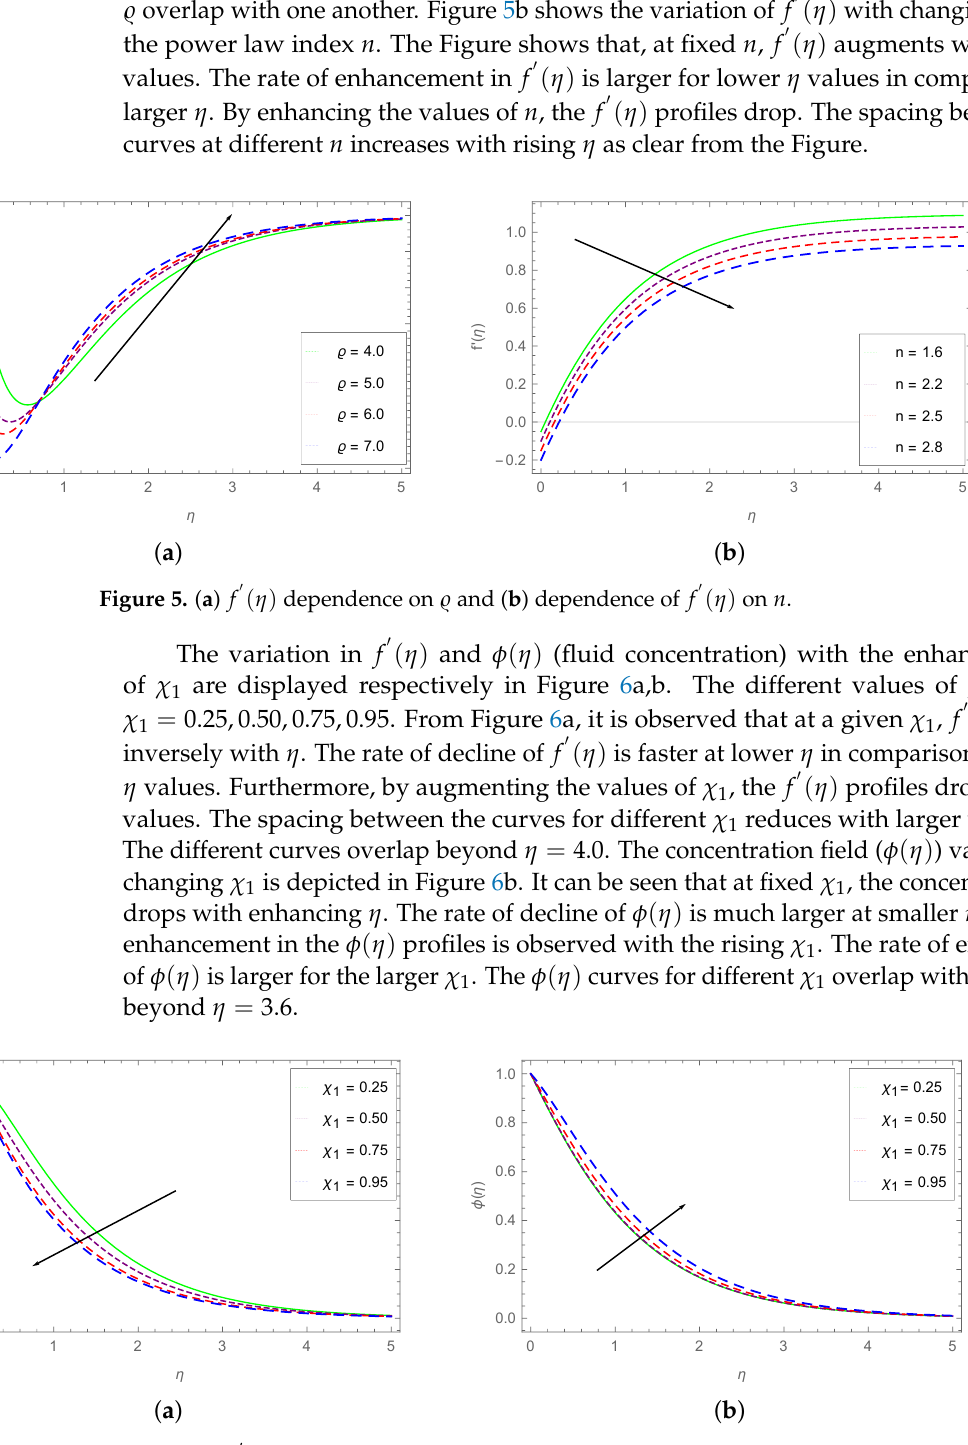
Figure 6. ( a ) f (cid:48) ( η ) variation with χ 1 and ( b ) dependence of φ ( η ) on χ 1